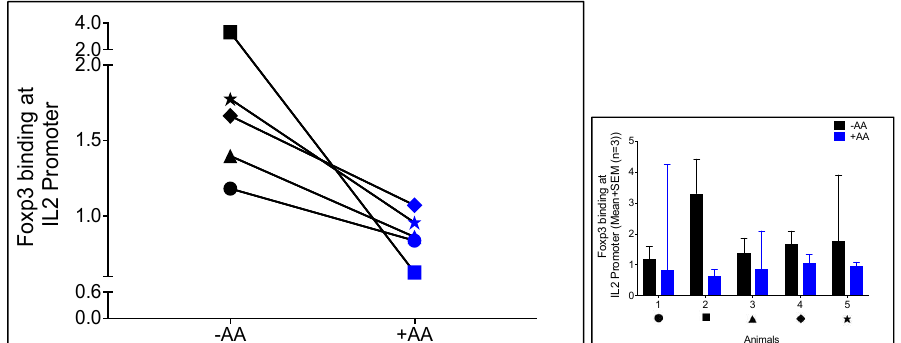
Figure 3. Anacardic acid blocks Foxp3 binding to the IL-2 promoter in virus-specific CD8 + T cells. Virus-specific CD8 + lymphocytes from FIV+ cats (>6 mo infection) were either untreated (black) or treated (blue) with AA at 20 μM for 24 h followed by co-culture with autologous Treg cells. Foxp3 ChIP followed by qPCR demonstrated a reduction in Foxp3 binding to the IL-2 promoter in each paired set ( n = 5, each symbol represents an individual animal, values for each animal in the left panel represents the average of three technical replicates). The panel on the right demonstrates Foxp3 binding at the IL-2 promoter in virus-specific CD8 + T cells for each animal (symbol under X-axis) in the untreated (black) and AA treated (blue) groups. Data is presented as the mean + SEM of three technical replicates.